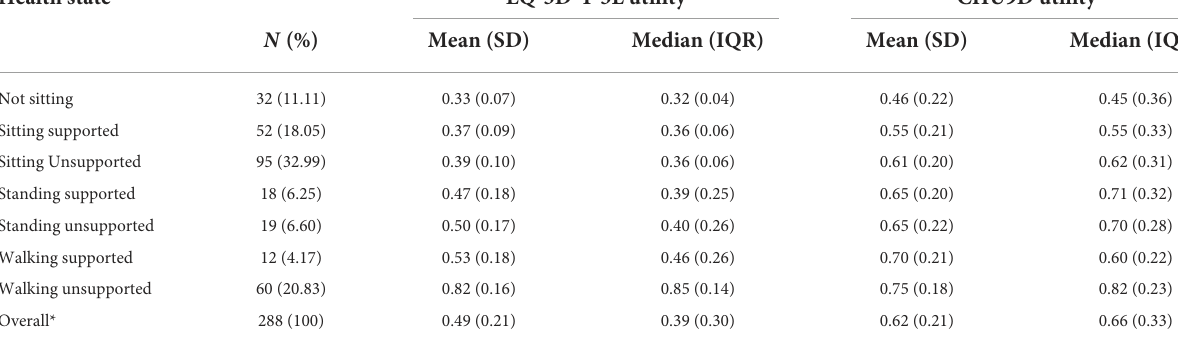
TABLE 5 HSUV derived from Type II and III SMA patients under 16 using EQ-5D-Y-3L and